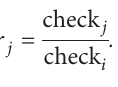
and U ) and the items ( I 3 4